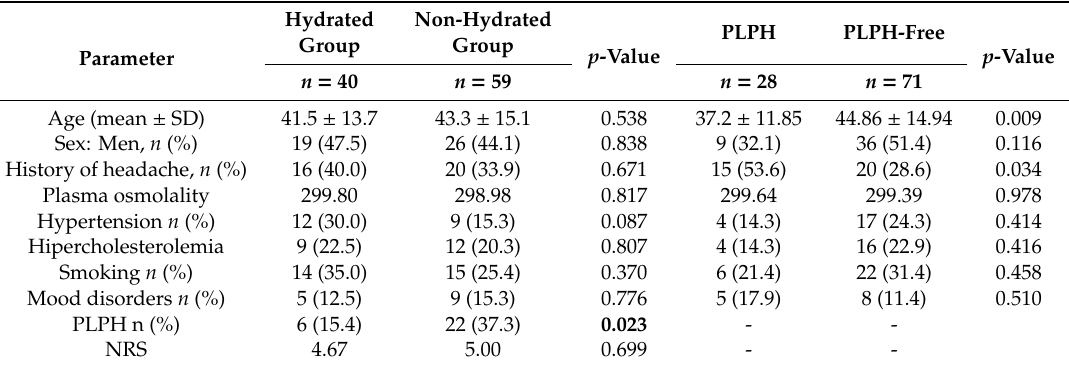
Table 1. Clinical characteristics of hydrated and non-hydrated patients; patients who developed post-lumbar puncture headache (PLPH) and PLPH-free